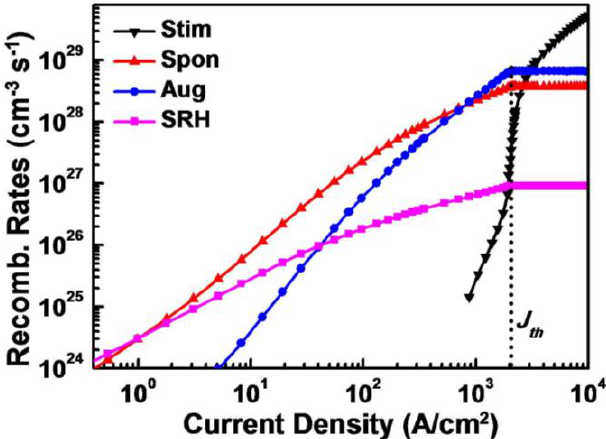
Figure 2. The calculated recombination rates of stimulated emission (black), spontaneous emission (red), Auger recombination (blue), and SRH recombination (magenta) of GaN-based LDs at various injection current densities.